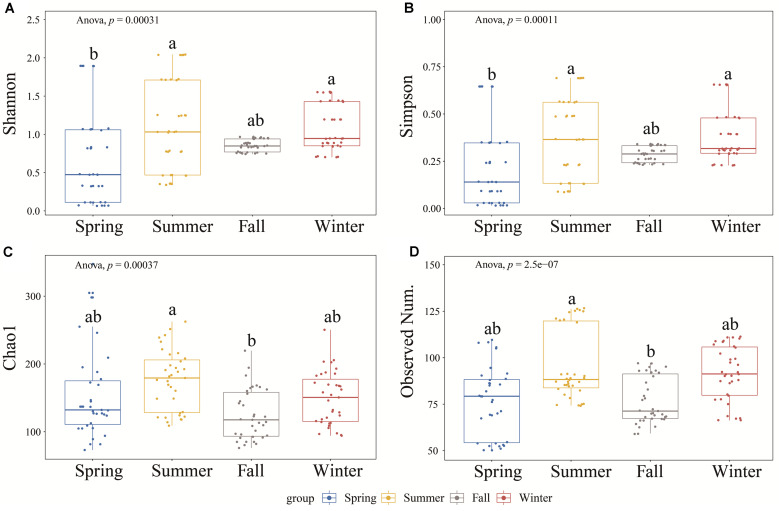
The α-diversity indices (A–D: Shannon, Simpson, Chao 1, and Observed Number of OTUs) among the four seasons by boxplot. The differences between any two groups were tested by Tukey’s HSD test, presented by lowercase letters on the plots.